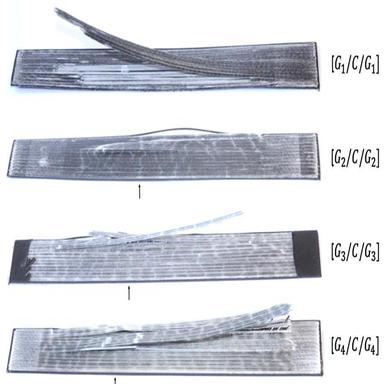
Image of failed samples for laminate configurations (m = 1–4). (Images were taken after the final failure, the arrows indicate typical locations of carbon fibre failure). (For interpretation of the references to colour in this figure legend, the reader is referred to the web version of this article.)